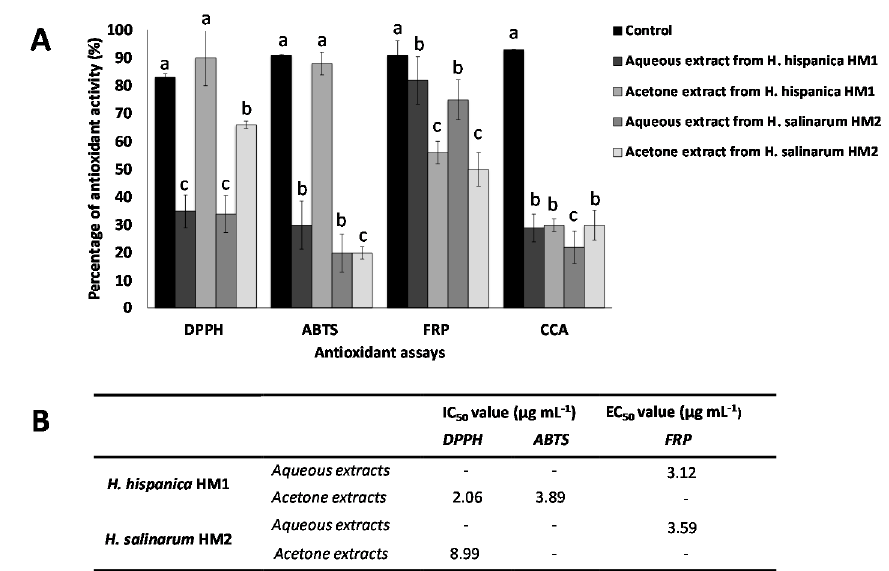
Figure 2. Antioxidant activity of aqueous and acetone extracts (1 mg mL − 1 ) obtained from the haloarchaeal strains H. hispanica HM1 and H. salinarum HM2, determined by DPPH (1,1-Diphenyl-2-picrylhydrazyl) and ABTS (2,2'-azino-bis(3-ethylbenzothiazoline-6-sulfonic acid)) radical scavenging assays, or FRP (Ferrous ion reduction potential) and CCA (Copper chelating activity). For each assay, the data were submitted to one-way variance analysis (ANOVA). Bars are followed by different superscript letters (a, b or c), which denote groups with significant differences according to the Duncan’s Multiple Range Test ( p < 0.05) ( A ). The half maximal inhibitory or effective concentration (IC 50 or EC 50 ) were calculated when the activity was higher than 65% ( B ). These values were normalized to the content of proteins and carotenoids in the extracts, being the protein concentration of the aqueous extract 47 and 30 µg per mg DW and the carotenoid content of 10 and 12 µg per mg DW, respectively, for H. hispanica HM1 and H. salinarum HM2.